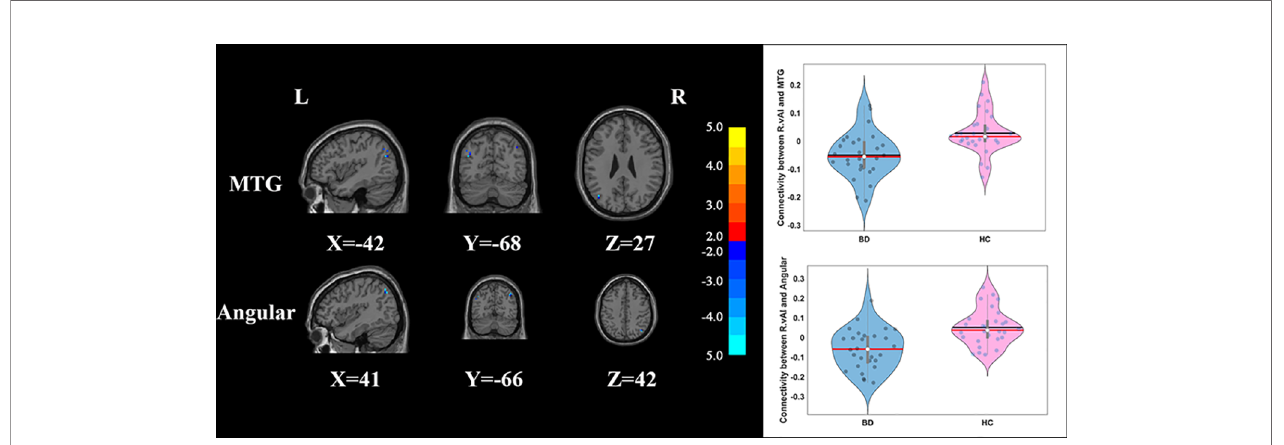
FIGURE 1 | Group differences of the whole-brain functional connectivity anchored in R_vAI: compared to HCs, BD patients showed signi fi cantly decreased functional connectivity between R_vAI and MTG, as well as R_vAI and angular (GRF corrected, p < 0.05, voxel Z value > 2.3). Blue indicates smaller values in BD. L, left; R, right; BD, bipolar disorder; HC, healthy control; R_vAI, right ventral anterior insula; MTG, middle temporal gyrus; GRF, Gaussian random fi eld.